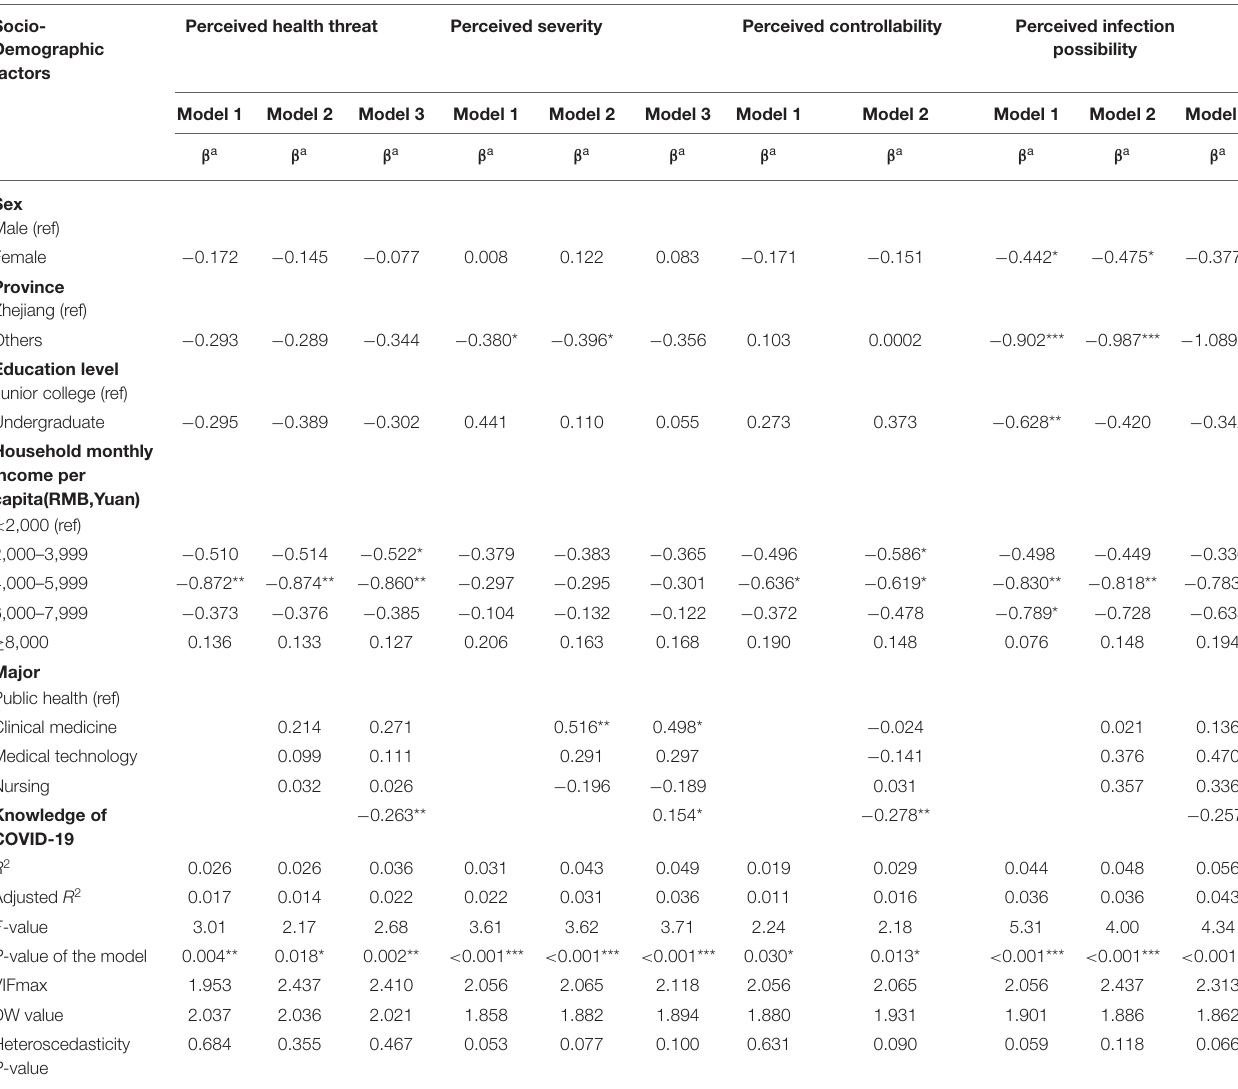
TABLE 4 | Multiple linear regression of the risk perception of COVID-19 among medical college students. Socio- Demographic